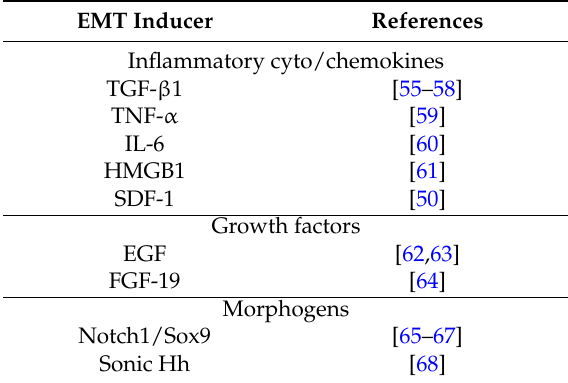
Table 1. Soluble factors inducing a “transitional” phenotype in cultured CCA cells. EMT